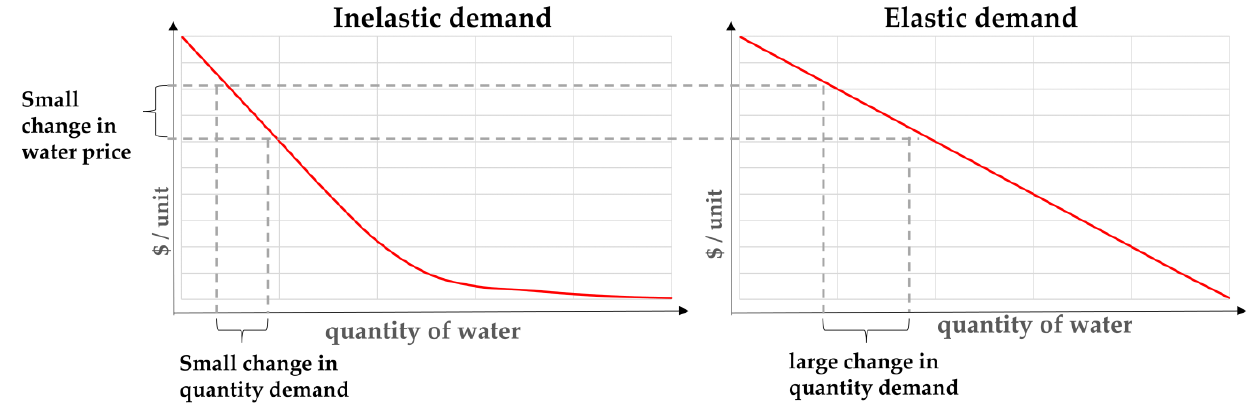
Figure 3. Elasticity of the price and consumption of water (adapted from [30]).